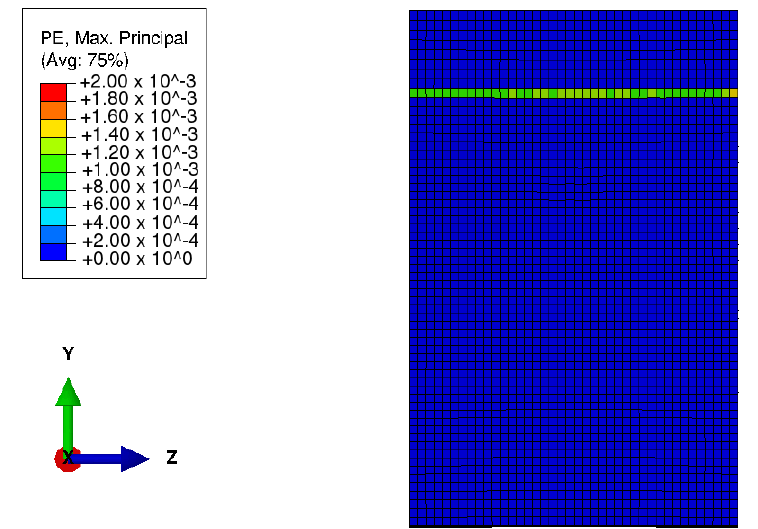
Figure 22. Plastic strains, developed on the outer surface of the top slab at its connection to the lateral wall right after the onset of cracking, as obtained from a thermomechanical simulation based on temperature-dependent and elasto-plastic material behavior, as well as on the prescription of one uniform surface temperature history; the results refer to the time instant 6 min and 3.6 s after the beginning of the fire